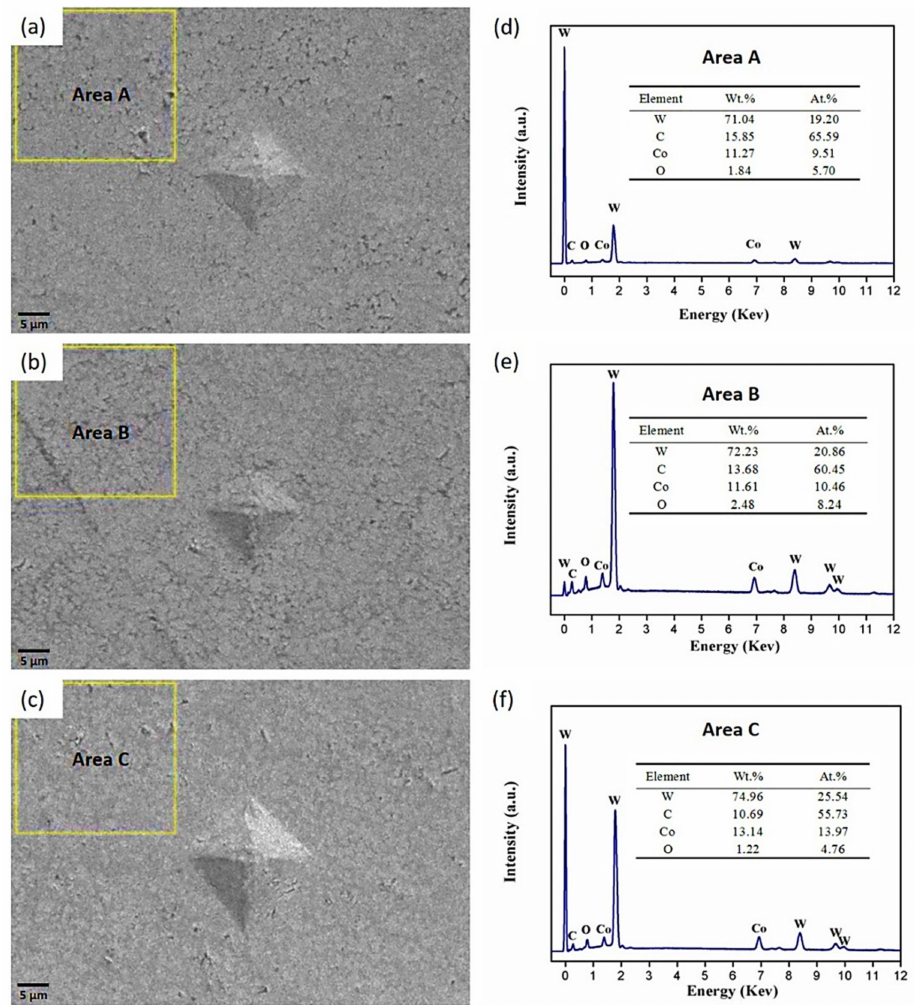
Figure 7. Indentation mark of as-sprayed ( a ), HT 800 ( b ), HT 1100 coating ( c ), and EDS analysis of area A ( d ), area B ( e ), and area C ( f